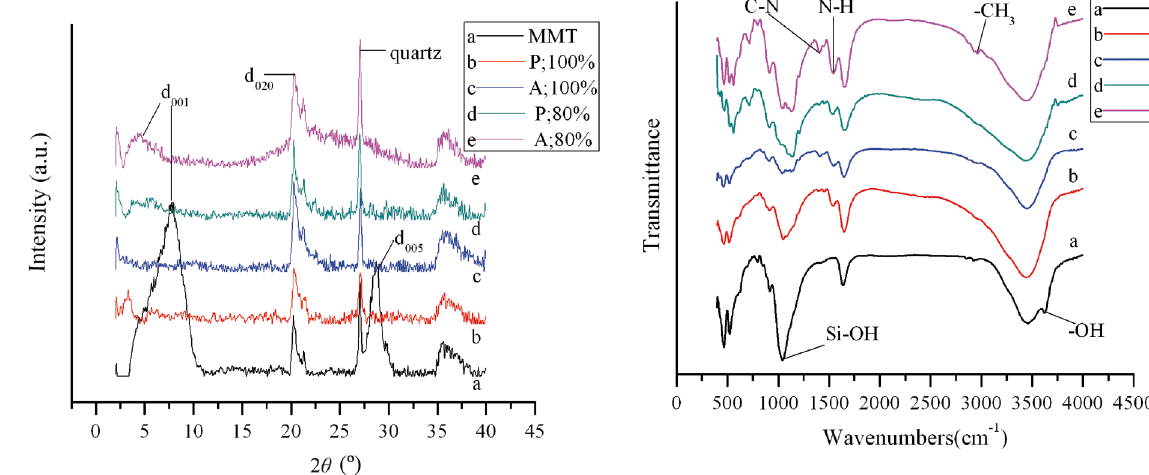
Figure 4 X-ray diffraction (XRD) patterns of BSA/KH570-MMT, MMT. P, sodium phosphate buffer solution; A, sodium acetate-acetic acid buffer